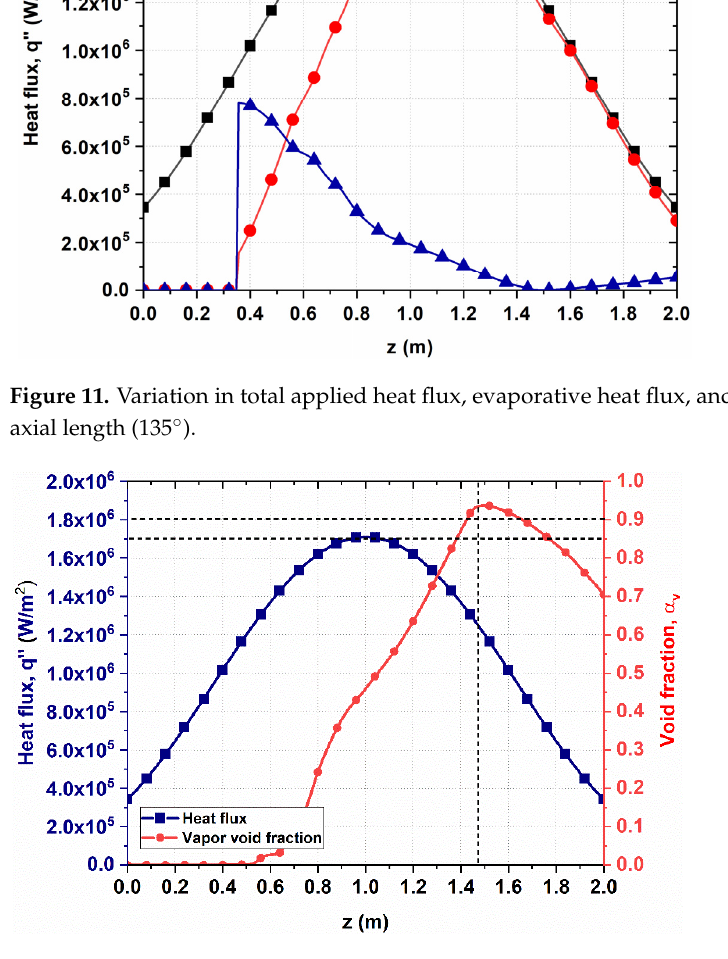
Figure 12. Evolution of near-wall void fraction at an azimuthal location of 135°.